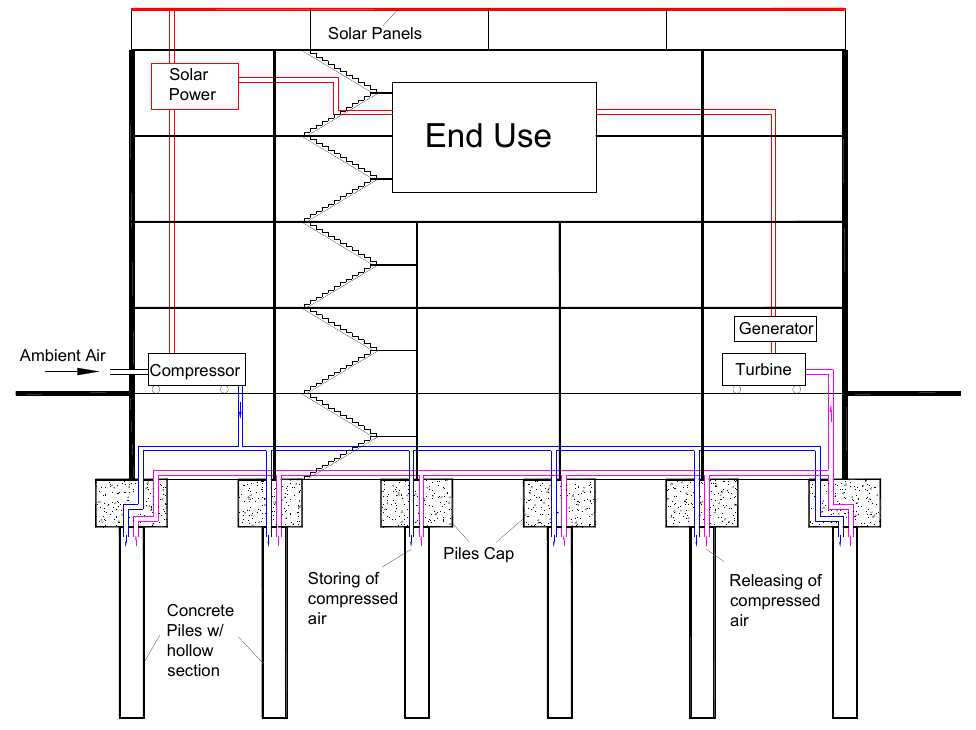
Figure 1. Proposed energy storage foundation system (Modified from [5]).